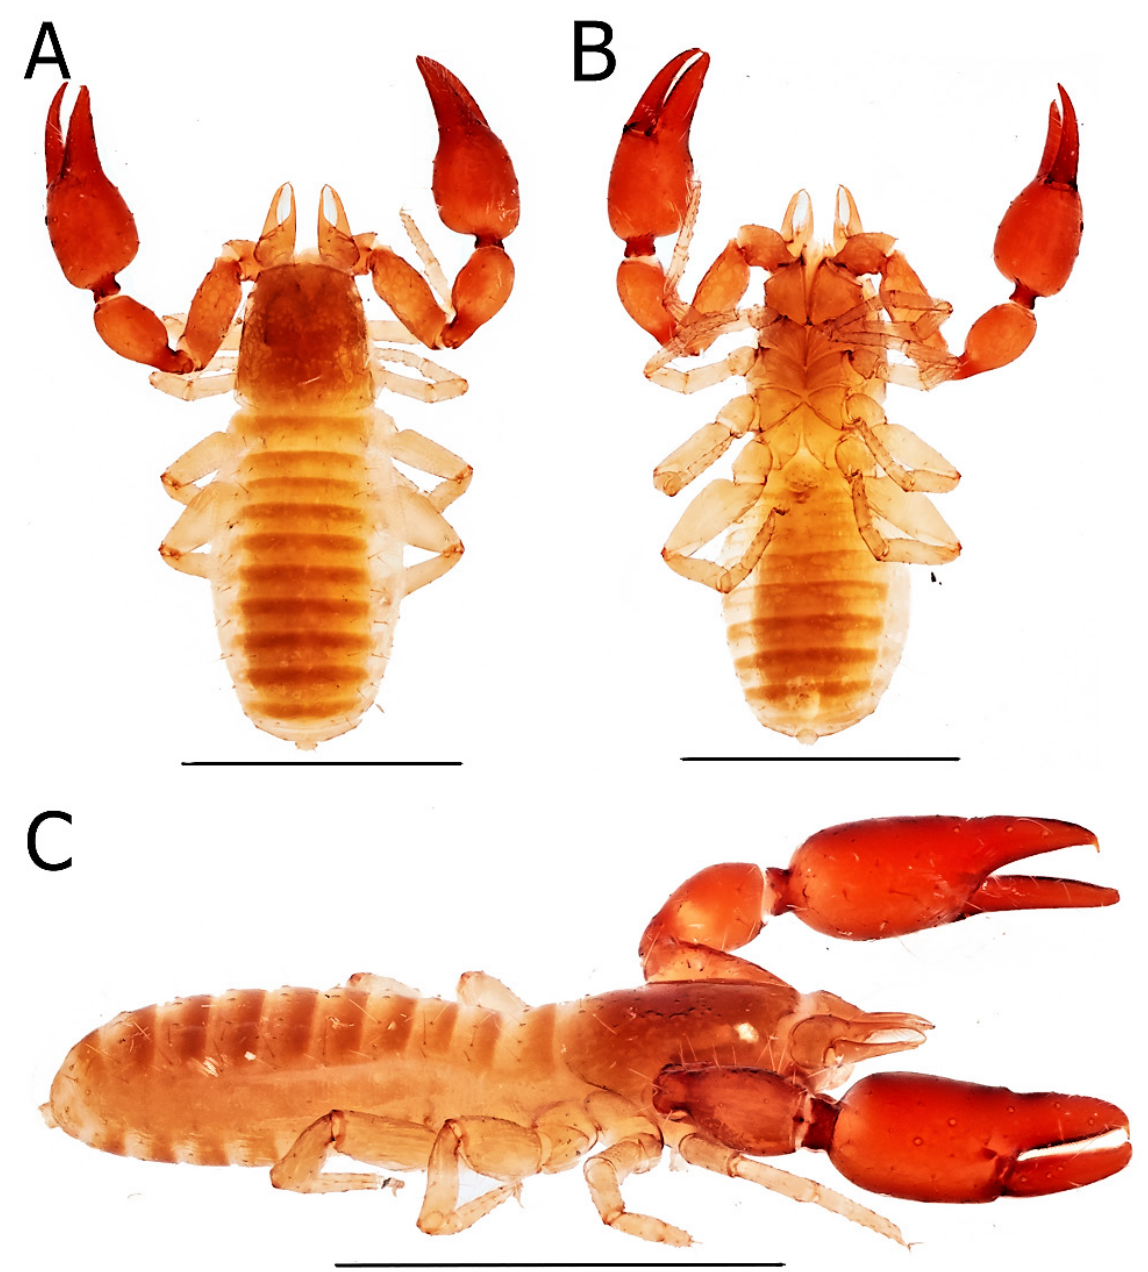
Fig. 4. Ideobisium kichwa sp. nov., allotype, ♂ (QCAZ). A . Habitus in dorsal view. B . Habitus in ventral view. C . Habitus in lateral view. Scale bars = 1